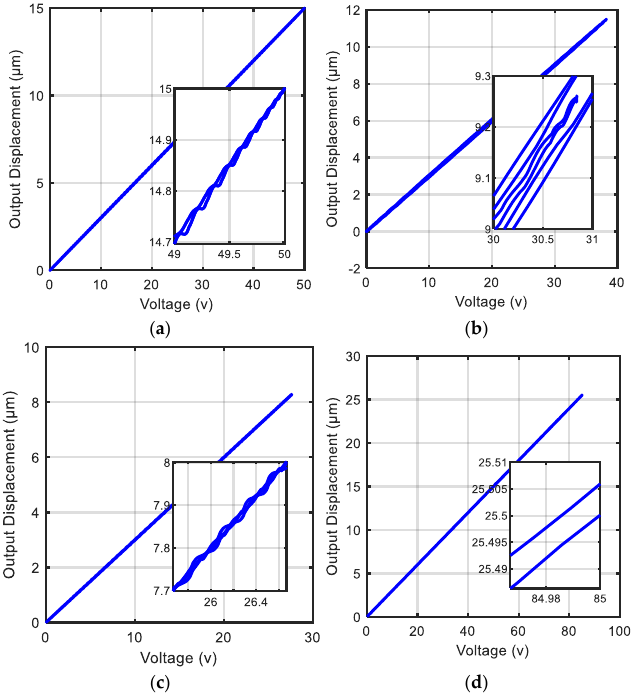
Figure 15. The effect of the proposed control scheme on hysteresis loops of the considered piezoelectric actuator. The loops shown were obtained by: ( a ) test reference D; ( b ) test reference E; ( c ) test reference F; and ( d ) test reference G.